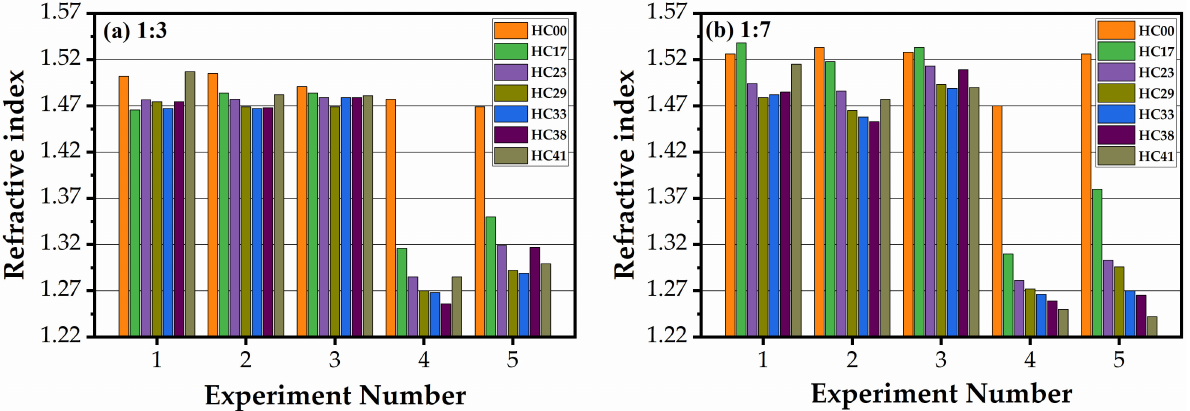
Figure 3. Change of refractive index of films (0 to 41 wt%, numbered from HC00 to HC41) and benzene-bridge content for ( a ) 1:3, and ( b ) 1:7 materials. The experiment number corresponds to (1) as-deposited (AD), (2) after soft baked in air for 30 min (SB-Air), (3) soft baked in N 2 for 30 min (SB-N 2 ), (4) hard baked in air for 30 min (HB-Air), and (5) hard baked in N 2 for 60 min (HB-N 2